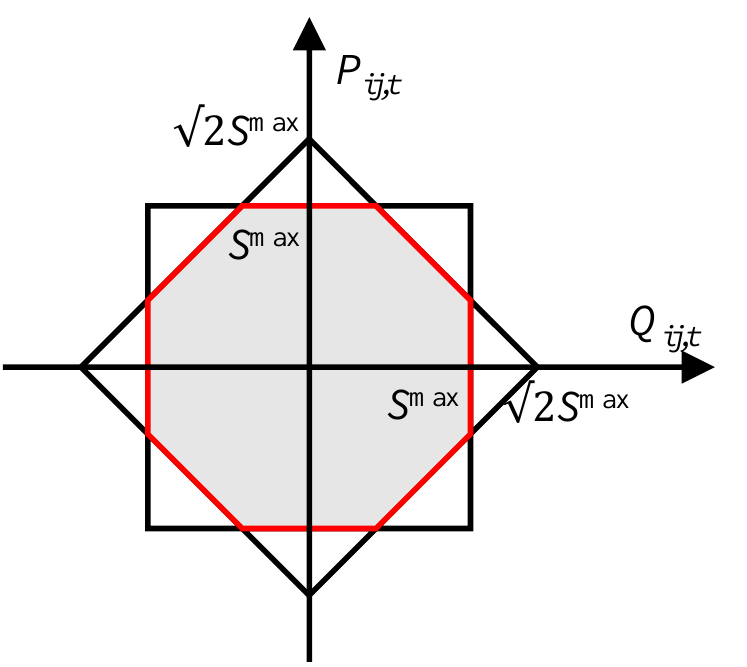
Figure 2. An illustration for